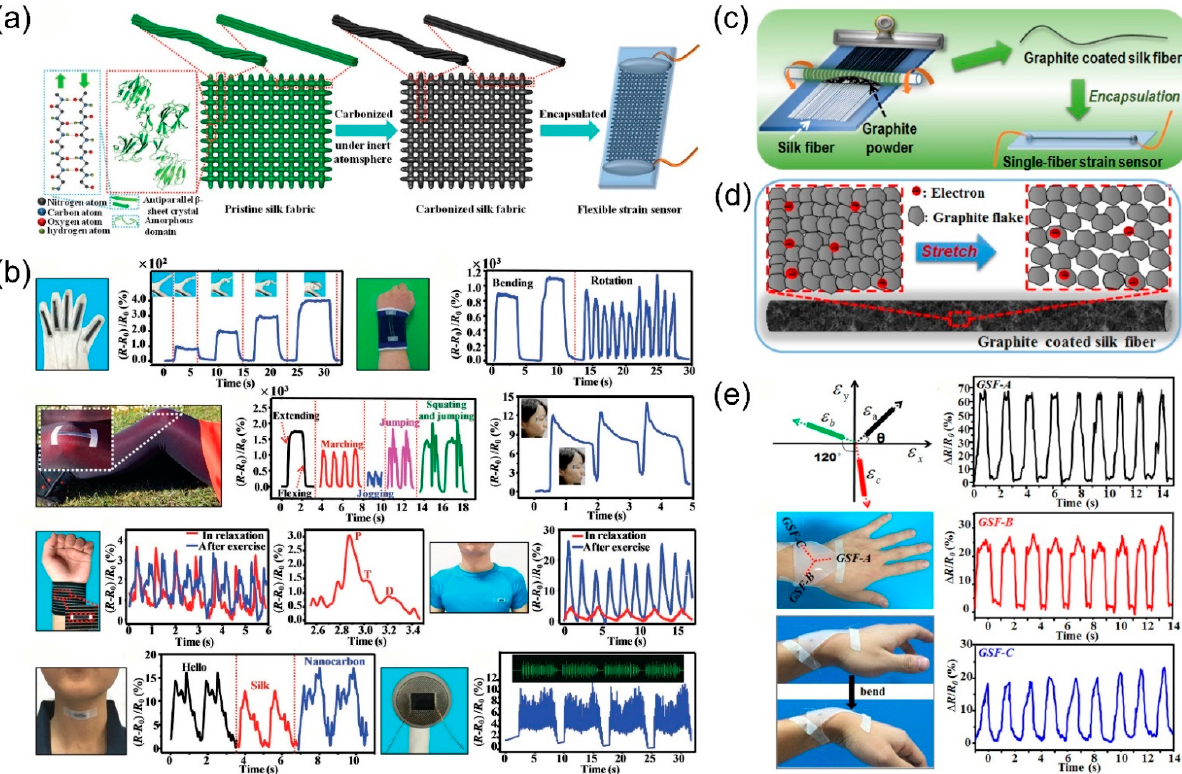
Figure 14. ( a ) Illustration showing the hierarchical structures and the fabrication of carbonized silk fabrics strain sensors; ( b ) detection of various human motions and sounds using the wearable carbonized silk fabrics strain sensors; Reprinted with permission from Ref. [109]. 2016, Wiley-WCH. ( c ) fabrication of sheath–core structured graphite and silk strain sensors through a dry-Meyer-rod-coating process; ( d ) schematic illustration of the sensing mechanism; and ( e ) integrated rosette-shaped GSF strain senor for multidirectional motion detection. Reprinted with permission from Ref. [111] 2016, American Chemical Society.